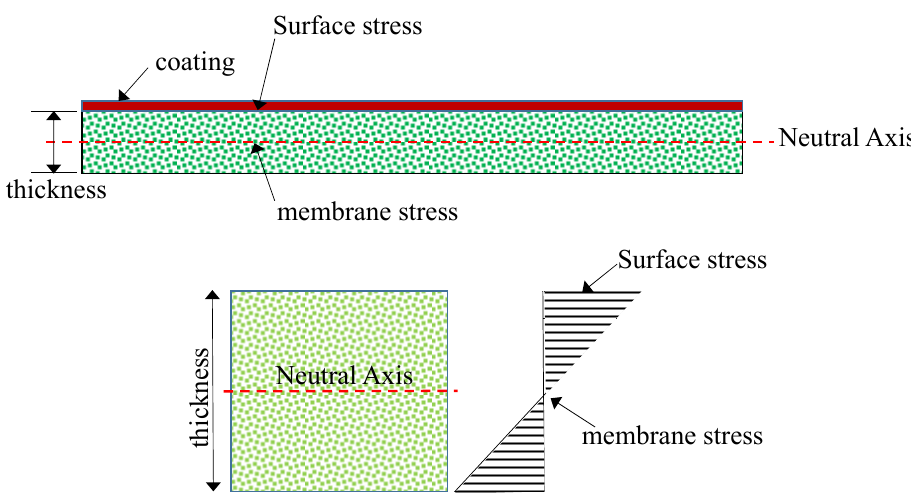
Figure 9. Definition of coating stresses and strain.